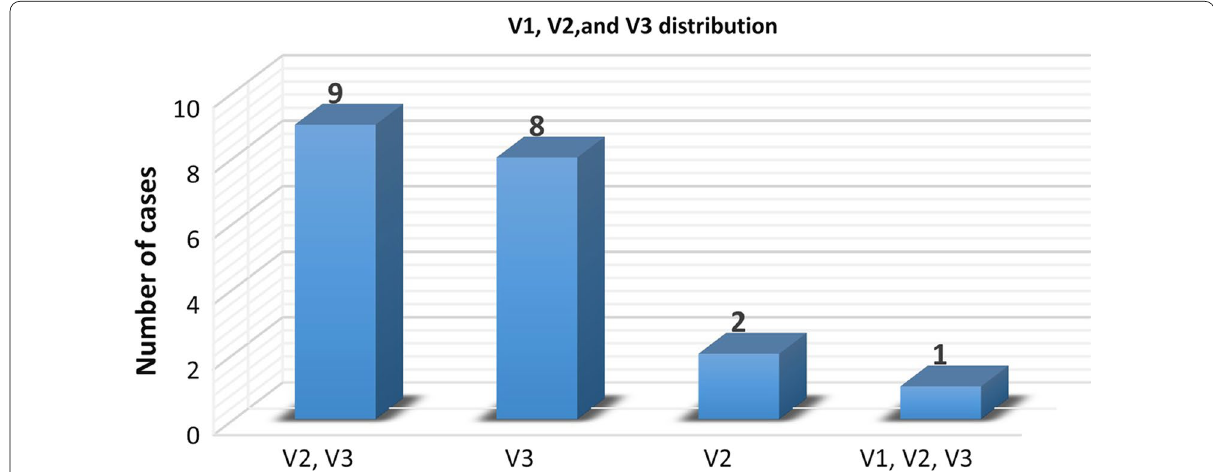
Fig. 3 Pattern of trigeminal neuralgia according to V1–V2–V3